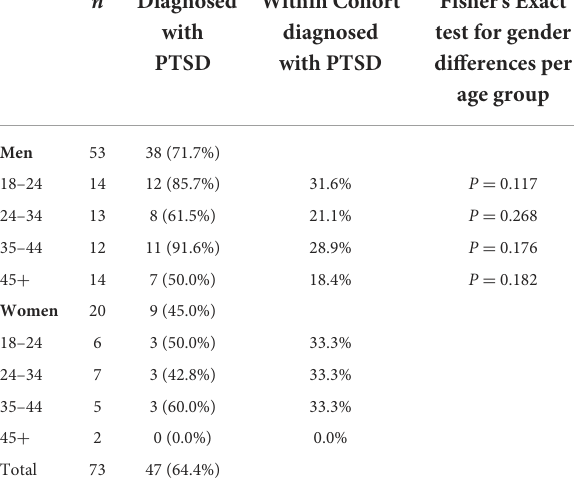
TABLE 1 PTSD occurrence relative to gender and age